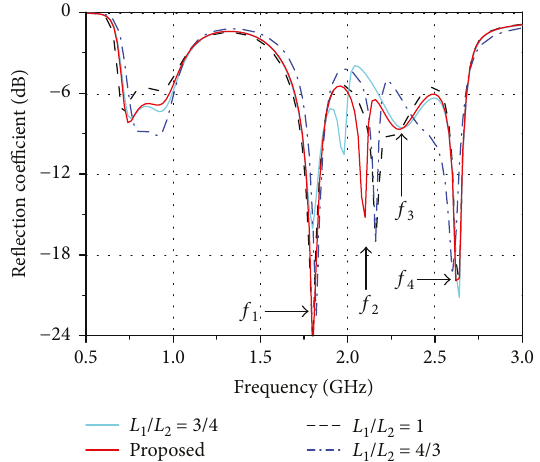
Figure 4: E ff ect of the ration w